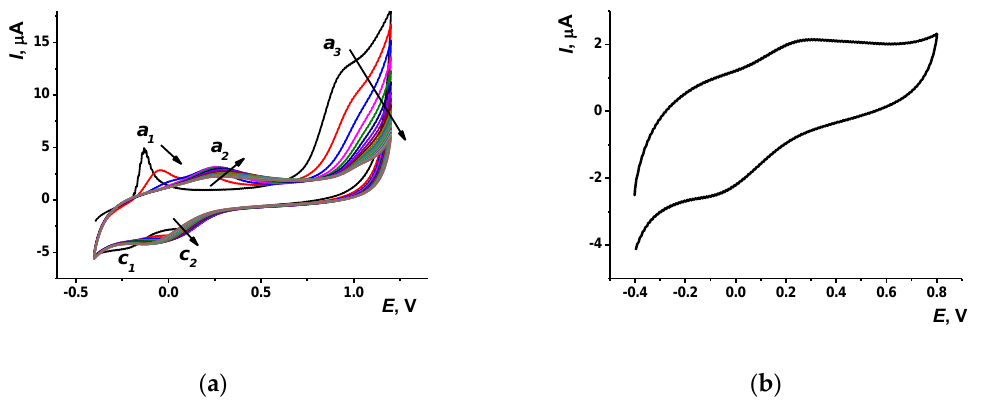
Figure 1. ( a ) Multiple cyclic voltammograms recorded on glassy carbon electrode in 0.025 M PB, pH = 7.0, containing 0.03 M NaCl, 0.25 mM Azure B, and 0.25 mM proflavine, scan rate 100 mV/s (20 cycles). Arrows indicate direction of the changes observed with increasing number of the cycles. ( b ) Cyclic voltammograms recorded with glassy carbon electrode covered with Azure B–proflavine copolymer (20 cycles) in 0.025 M PB with no monomers.